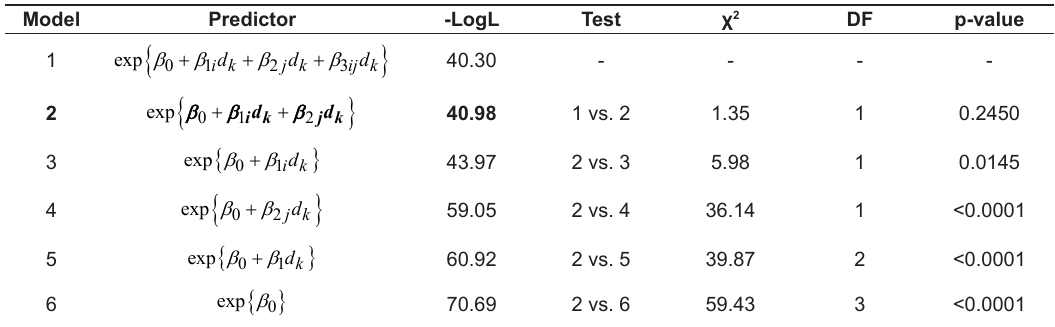
Table 2. Likelihood ratio tests for the different models fitted to the experiment data involving E. grandis and L. molleoides .